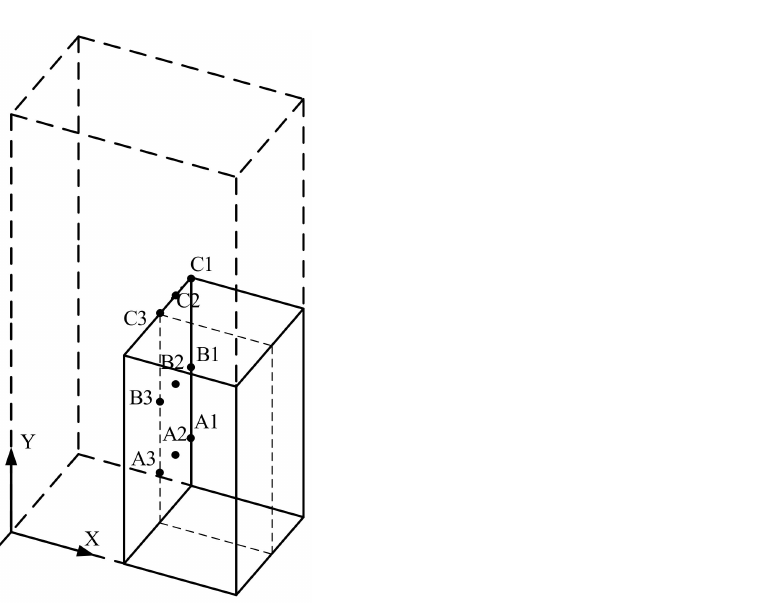
Figure 15. Metallographic specimen with test